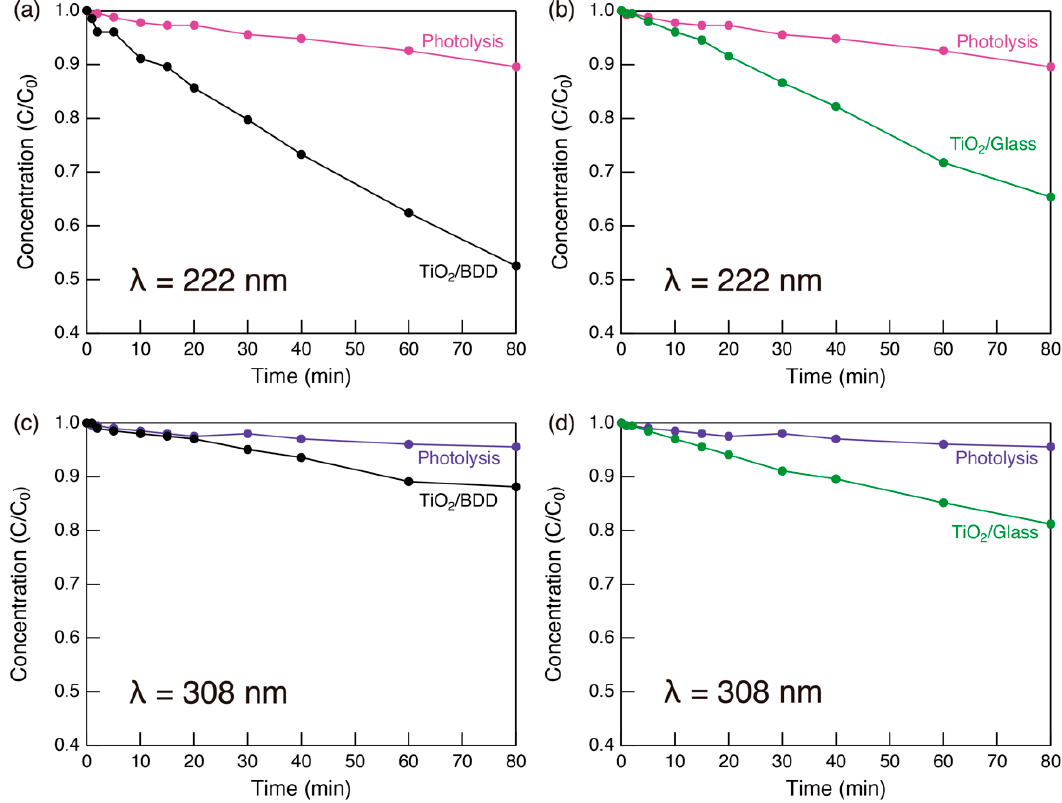
Figure 6. Time dependence of MB concentration, estimated from the visible spectra during the photocatalytic activity testing of ( a , c ) mesoporous TiO 2 /BDD and ( b , d ) mesoporous TiO 2 /glass under ( a , b ) 222 nm and ( c , d ) 308 nm UV light.